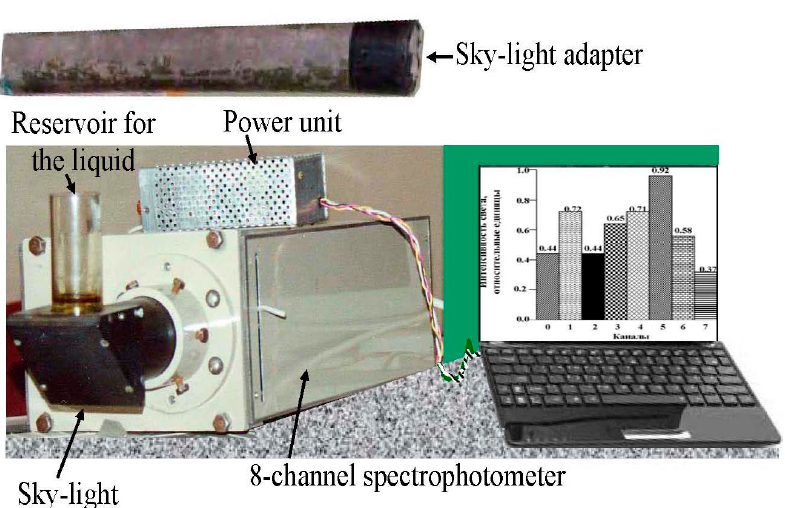
Figure 3. View of an adaptive 8-channel optical universal spectrophotometric decision-making system (US-8) used to study the characteristics of in situ spectral water and in the laboratory during water sampling.